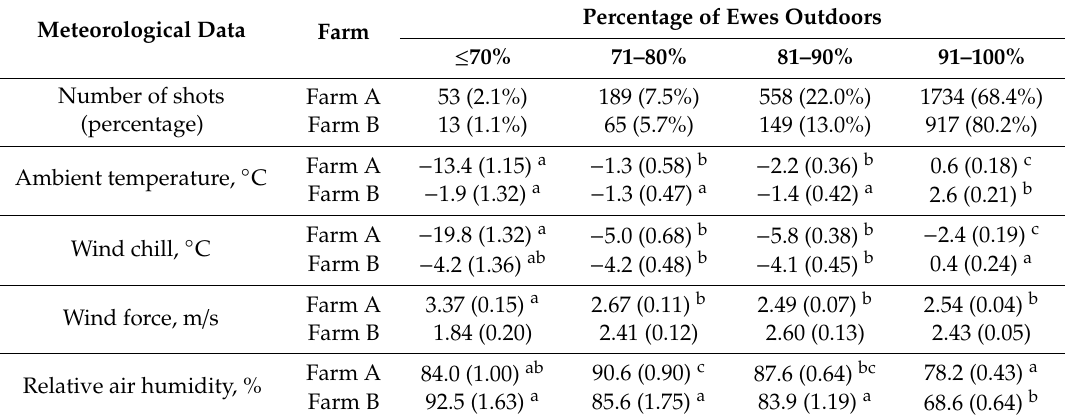
Table 1. Number and percentage of observations and average climate parameters (with standard errors in brackets) depending on the percentage of ewes outdoors in Farms A and B. Means without a common superscript letter in the same rows are significantly di ff erent ( p < 0.05, Tukey’s post-hoc